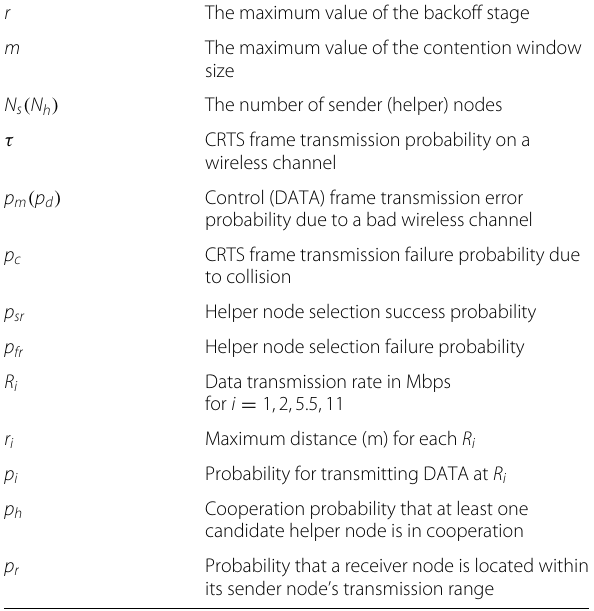
corresponds to Table 1 Definition of system parameters